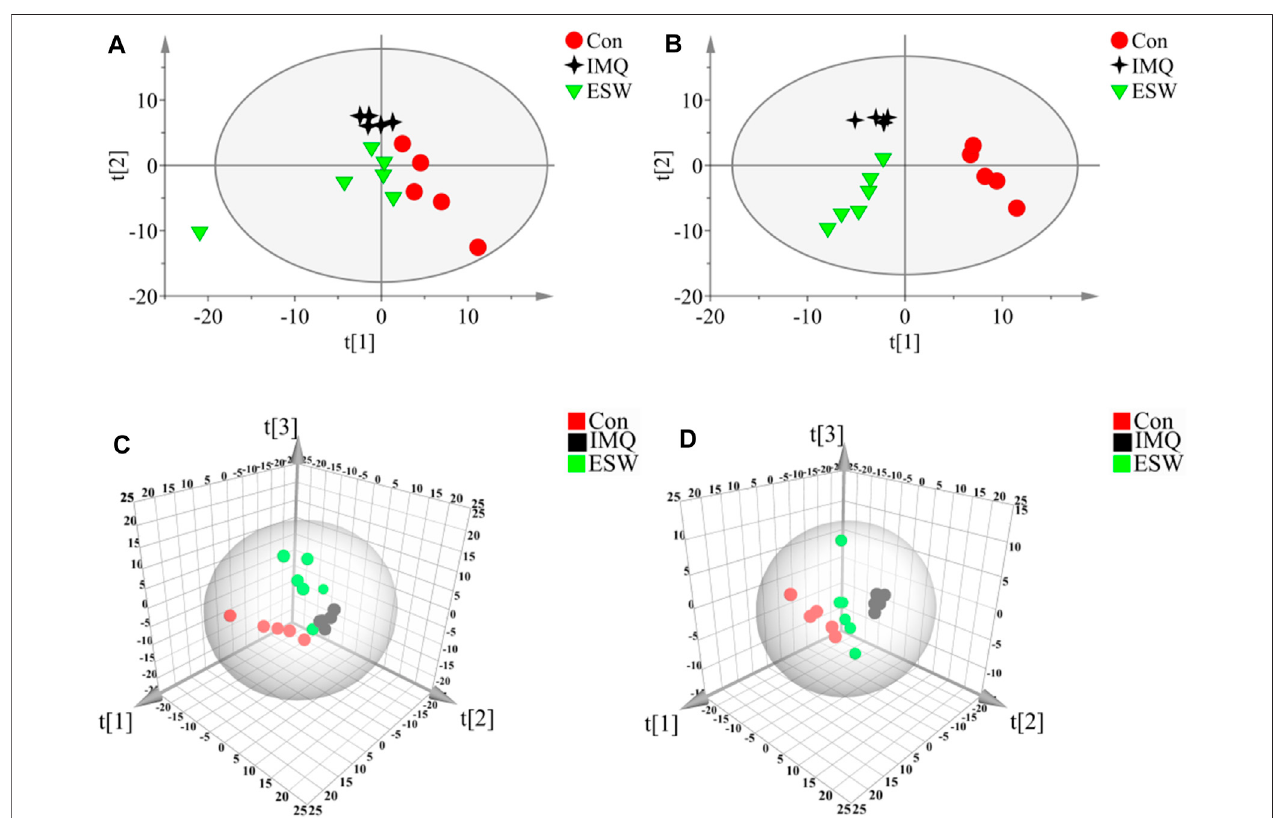
FIGURE 4 | PCA and PLS-DA scores plots of mouse spleen data in Con group, IMQ group, and ESW group. (A) Dynamic mean-centered PCA 2D score plot of mouse spleen data. (B) Dynamic mean-centered PLS-DA 2D score plot of mouse spleen data. (C) Dynamic mean-centered PCA 3D score plot of mouse spleen data. (D) Dynamic mean-centered PLS-DA 3D score plot of mouse spleen